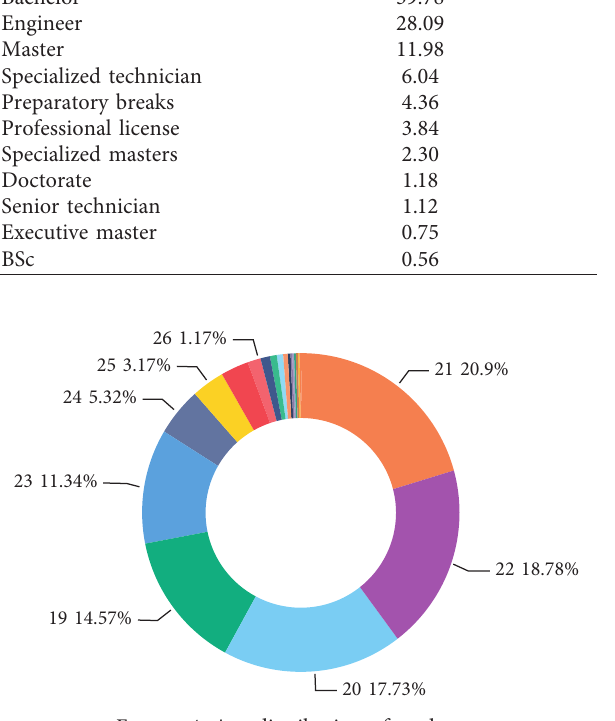
Figure 4: Age distribution of students.